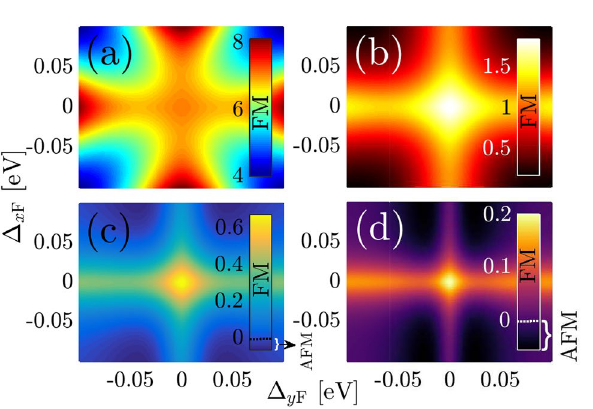
Figure 9. The behavior of the correlation function at E potential (cid:31) x F and distance R for ϕ R trend at a certain R > R c decreases with the distance R labeled by red solid dots.